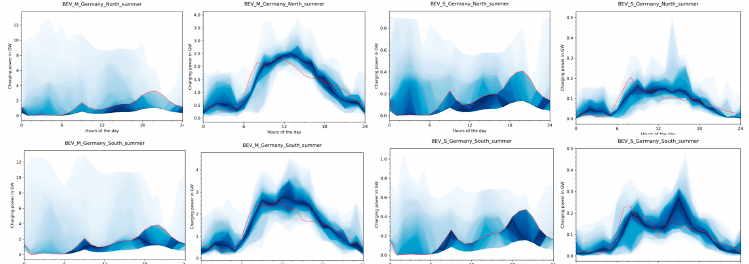
Figure A5. Daily probability distributions for total charging (controlled and uncontrolled) of medium and small sized BEV fleets in Northern Germany (top row) and Southern Germany (bottom row) in summer hours (3600–5760). The first and the third column show S1 results and the second and third column show S2 results. A case of completely uncontrolled charging is shown as red line.